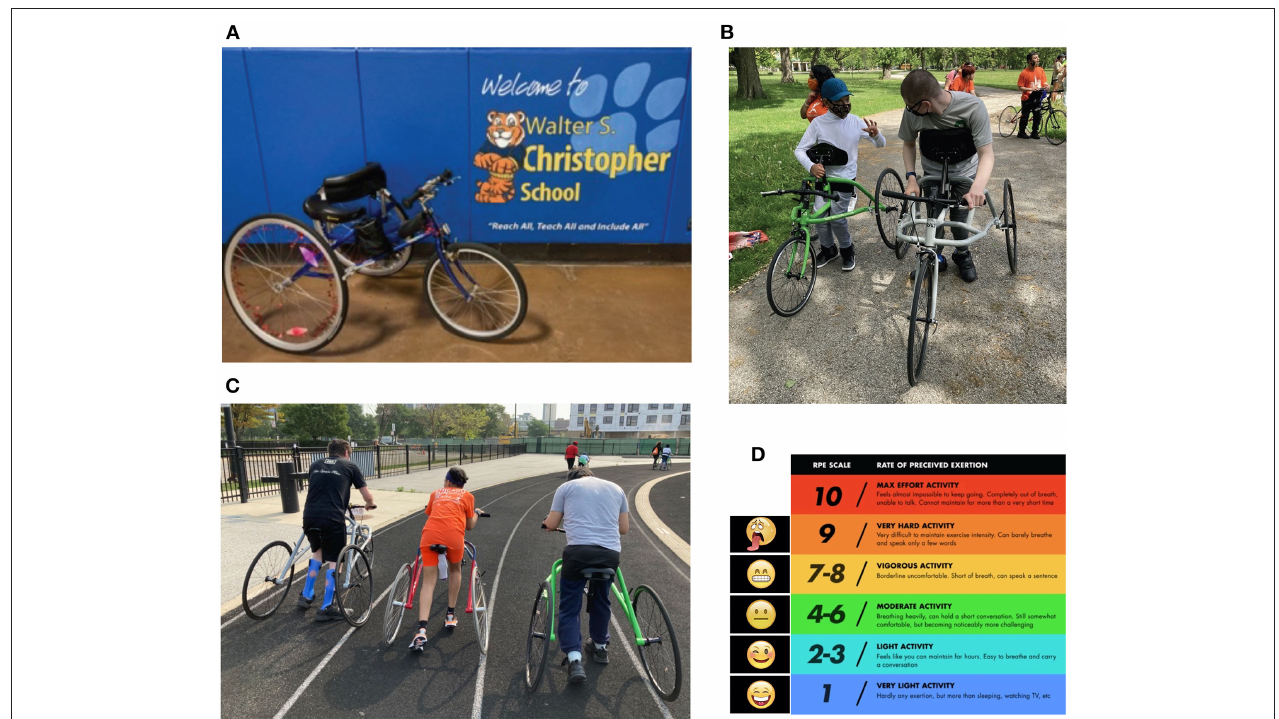
FIGURE 1 | (A) Running frame example. There are 3 wheels, a seat (styles of seat vary in shape and dimension), and a chest plate for additional trunk support. The front wheel is held steady with the use of a damper. Bicycle style breaks on the front wheel allow athletes to stop and wheel locks on one or both back wheels secure the frame for mounting and dismounting. The model shown here is by Petra ( Peterson et al., 2015). (B) Front view of athletes using a running frame during a social and emotional learning (SEL) teamwork activity at practice. Both frames are by RAD (Black, 2021). (C) Back view of running frames in use during an endurance portion of practice by three athletes on a track to show relative width of the back wheels; they are wide enough for stability and fit through ADA-compliant doorways. The frames on right and left are RAD (Black, 2021), and middle is Eagle Sportschairs (Ewing, 2021). (D) Rate of perceived exertion (RPE) scale image used by athletes to report their perceived level of effort. This image was shown on shared screen during virtual sessions, and on a laminated index card during in-person